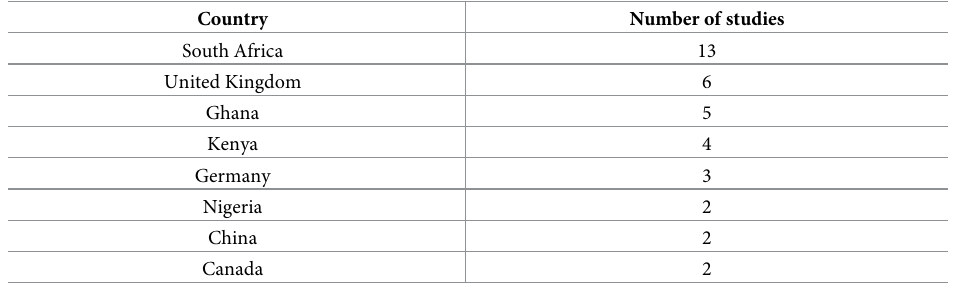
Table 2. Top countries contributing to the literature on OER in